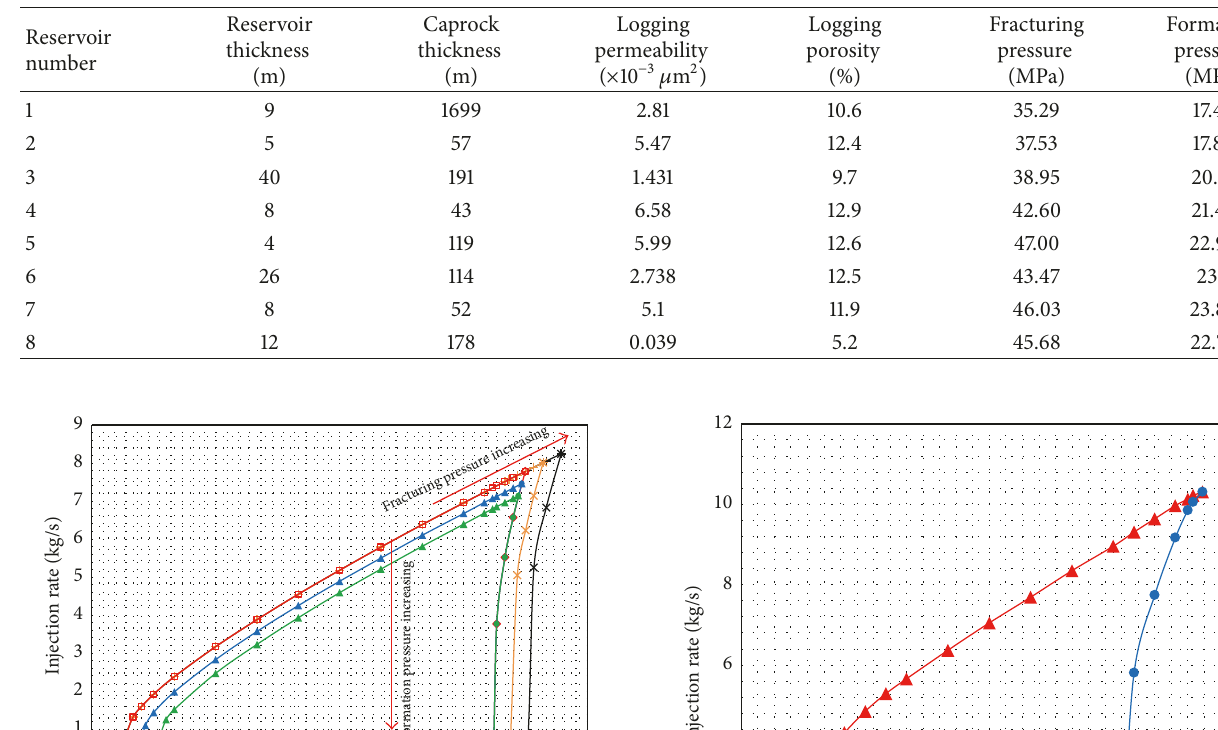
Table 8: The parameters of reservoir-caprock combination units in Shenhua CCS project [13].